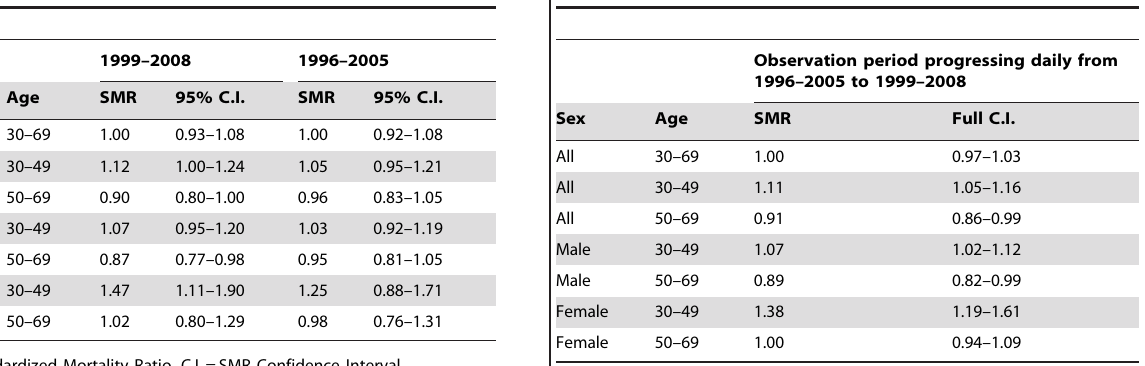
Table 2. Traditional approach for two 10-year observation periods, three years apart.